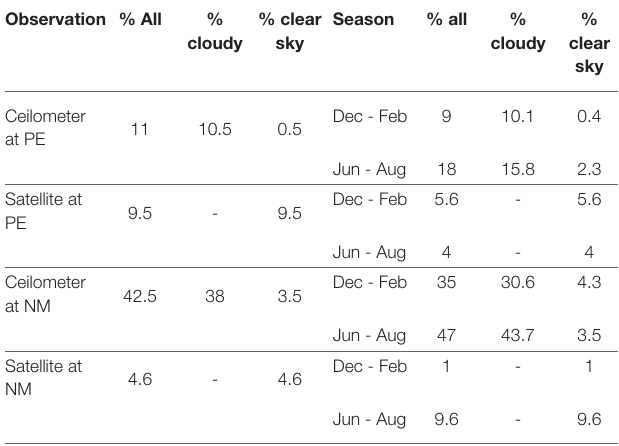
TABLE 4 | Presentation of the blowing snow frequencies over the 2011–2016 time period at Princess Elisabeth and Neumayer stations, as retrieved from the two different sensors individually (the whole time series is considered for each sensor, no time collocation is applied). Observation %